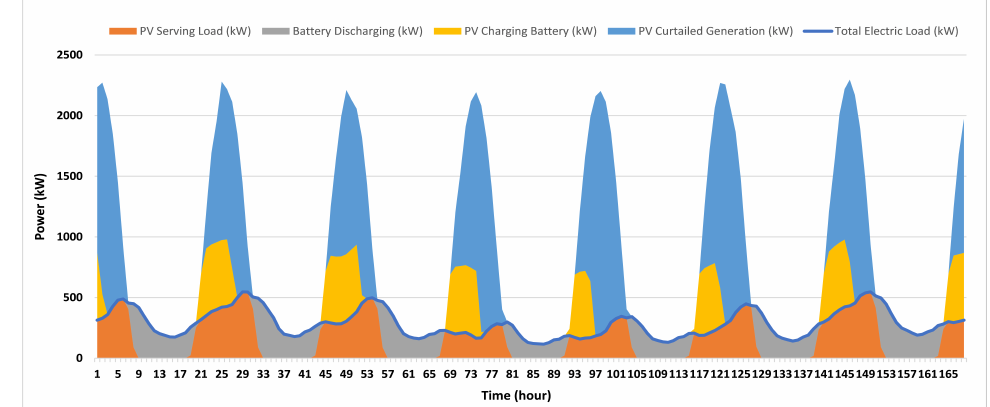
Figure 10. Microgrid operation during a week in the rainy season: Case 1.